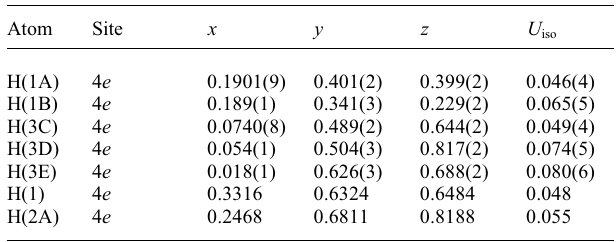
Table 2. Atomic coordinates and displacement parameters (in Å 2 )